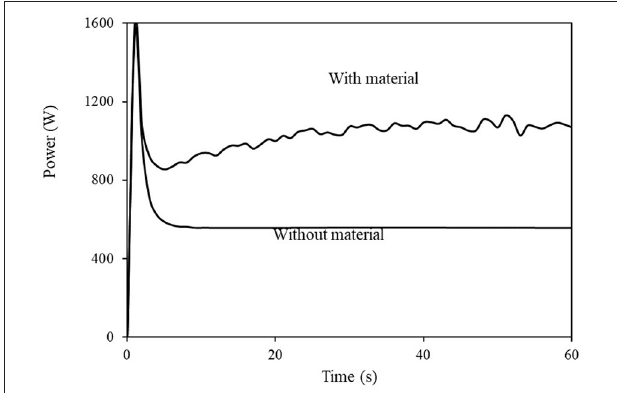
FIGURE 2 | Examples of power vs. time traces of the grinder without material and with 200g torrefied un-densified material.